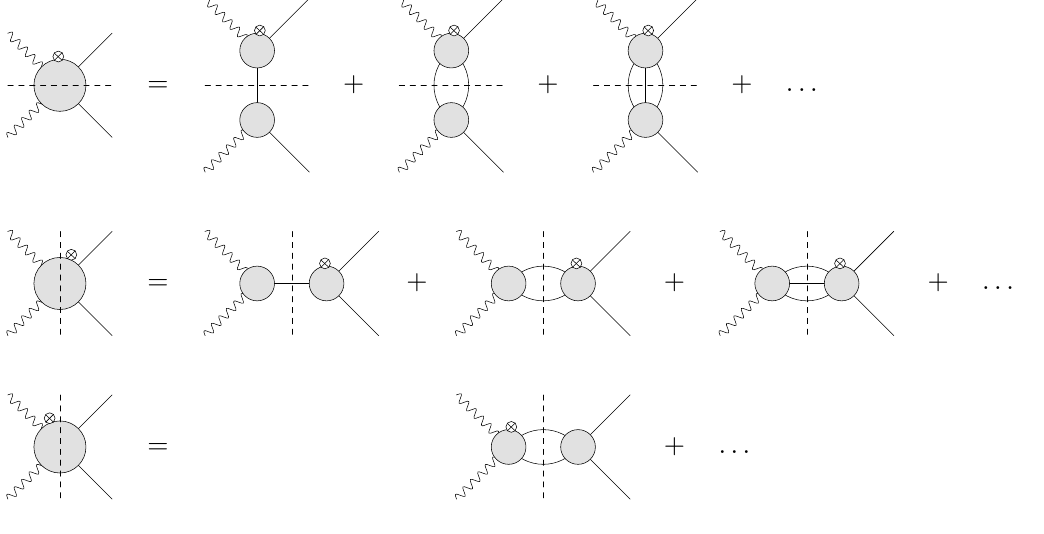
Figure 4 . The contribution of different intermediate states to the discontinuities in γ ∗ γ ∗ γ → 2 π . The last diagram denotes ππ rescattering: the process γ ∗ γ ∗ γ → 2 π itself reappears as a